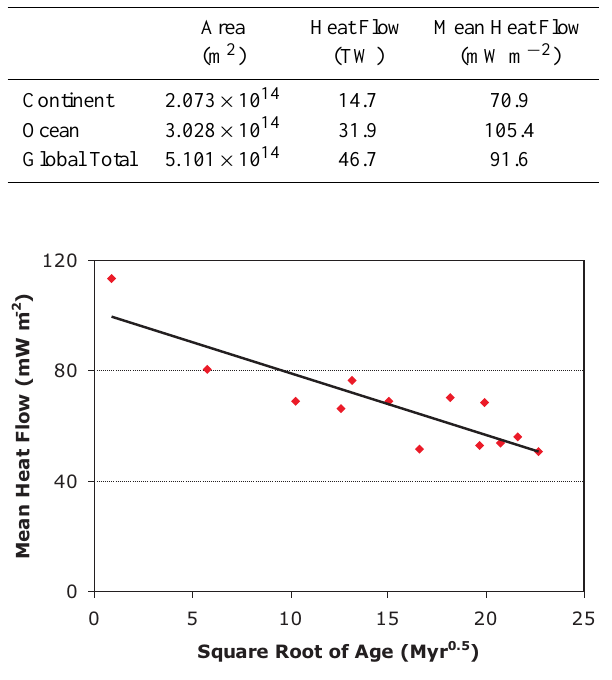
Fig. 12. A plot of the average heat flow for each geology category as a function of the square root of its mean age. There is a trend in the data, of decreasing mean heat flow with increasing age. If one excludes the very oldest datum (the Archean – which stretches over a very long geologic age) and the very youngest data (these cate- gories have very few measurements), there is a strong correlation. While the correlation of heat flow with geology could apply without a correlation between mean heat flow and age; the fact that such a correlation exists does lend some support that this fundamental as- sumption might have some merit. The correlation is strong enough ( R 2 =0.75) that it certainly seems better to take it into account than ignoring